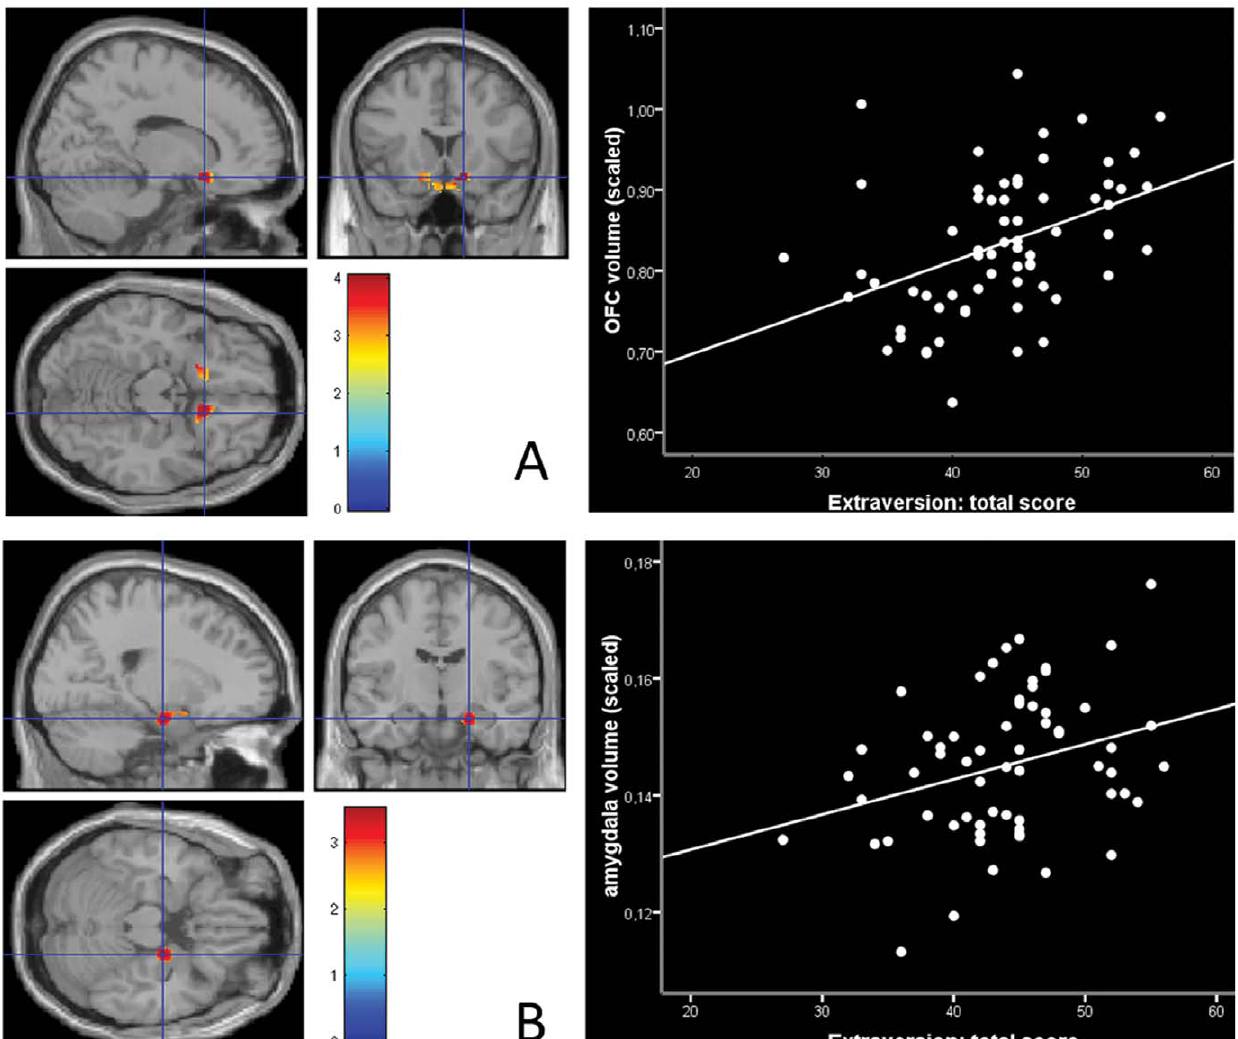
Figure 1. Correlations of Extraversion and volume in the OFC and amygdala. A) Positive correlation of extraversion and volume of the right orbital frontal gyrus scaled for total gray matter volume (r=.33; r partial =.47 when neuroticism and age were partialled out) . B) Positive correlation of extraversion and right amygdala volume scaled for total gray matter volume (r=.31, r partial =.39 when neuroticism and age were partialled out). Mean volume in ml of the significant voxels was extracted per subject and divided by total GM volume. In the correlation plots, mean volume of the significant amygdala and ofc region is depicted in scaled volume in ml * 10 2 3 .